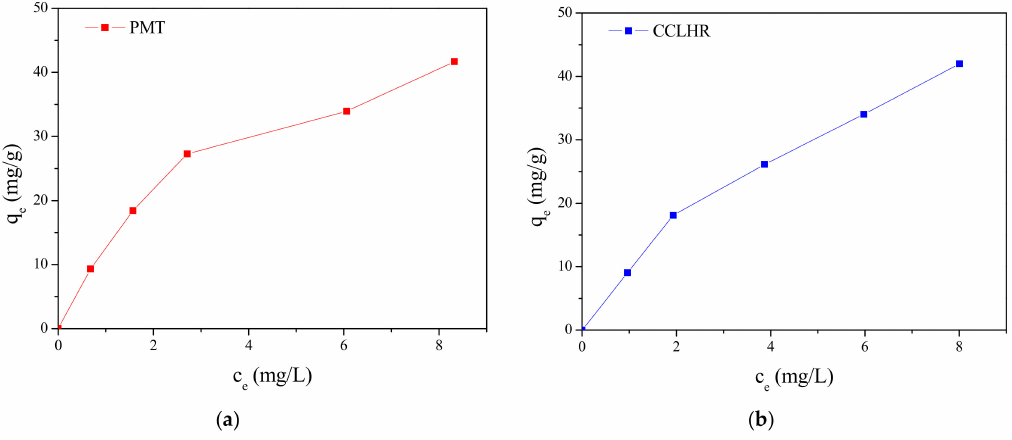
Figure 5. Adsorption isotherm of MB: ( a ) PMT, ( b )